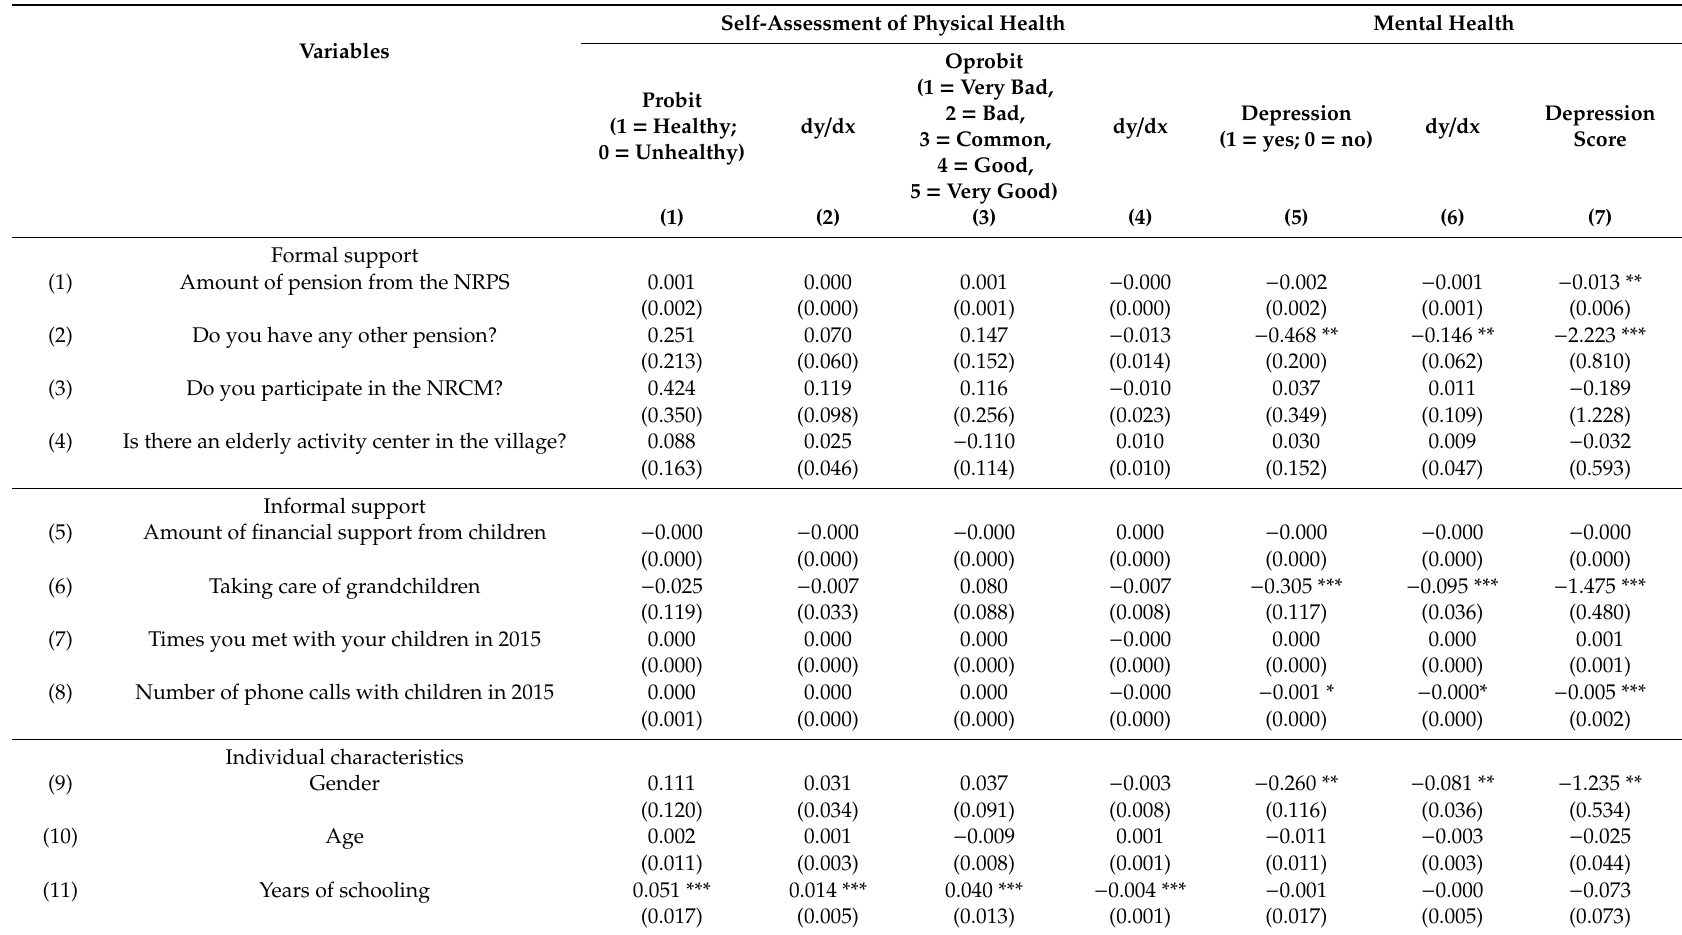
Table 4. The e ff ects of social support on the physical and mental health of the rural